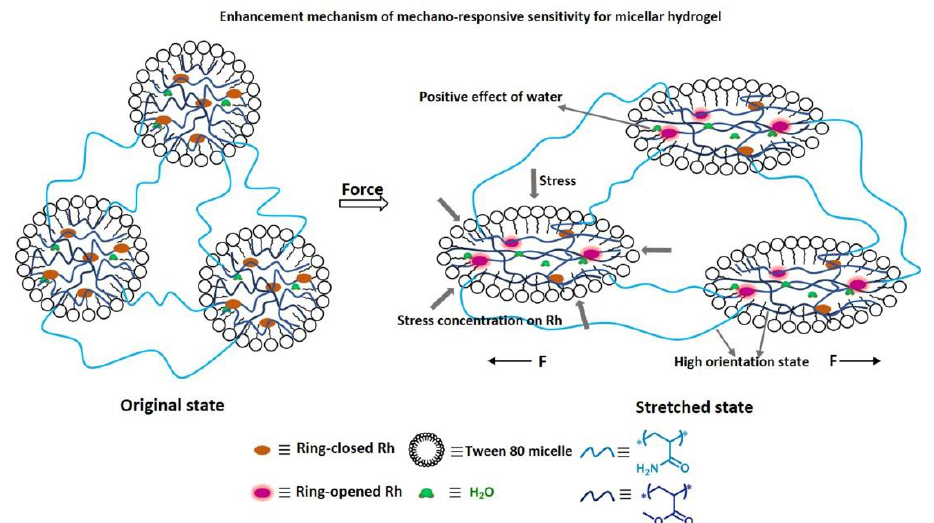
Figure 6. The enhancement mechanism of mechanoresponsive sensitivity for micellar hydrogel: (1) water favoring the activation of Rh; (2) stress concentration on Rh promoting the cleavage of the linkages in the Rh; (3) easy to reach high orientation state for the Rh-crosslinked chains contributing to the mechanoactivation of Rh.